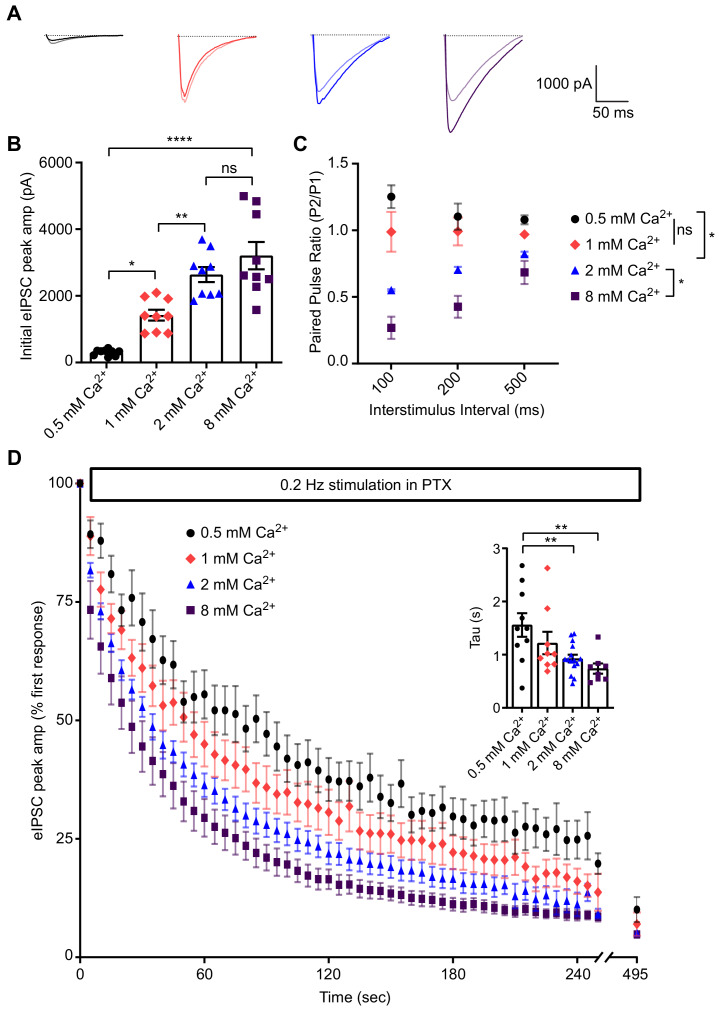
PTX can be used to compare release probability of inhibitory synapses.(A) Example traces of paired pulse responses at an interstimulus interval of 100 ms in 0.5 mM Ca2+ (pulse one black, pulse two gray), 1 mM Ca2+ (pulse one pink, pulse two light pink), 2 mM Ca2+ (pulse one blue, pulse two light blue) or 8 mM Ca2+ (pulse one purple, pulse two light purple). (B) Quantification of initial peak amplitude of eIPSC in different Ca2+ concentrations. Increasing Ca2+ concentration increases the initial peak eIPSC amplitude, consistent with increased release probability (one-way ANOVA F(3,32) = 27.24, p<0.0001, Tukey’s post-hoc testing 0.5 mM Ca2+ vs 1 mM Ca2+ p=0.0160, 1 mM Ca2+ vs 2 mM Ca2+ p=0.0079, 2 mM Ca2+ vs 8 mM Ca2+ p=0.3821, 0.5 mM Ca2+ vs 8 mM Ca2+ p<0.0001, n = 9 all groups). (C) Paired pulse ratio recorded from cells in different Ca2+ concentrations. Increasing Ca2+ concentration decreased paired pulse ratio, consistent with increased release probability (two-way ANOVA interaction F(6,26) = 2.801, p=0.0308, interevent interval factor F(2,26) = 2.220, p=0.1287, Ca2+ concentration factor F(3,26) = 43.55, p<0.0001, Tukey’s post-hoc testing 0.5 mM Ca2+ vs 1 mM Ca2+ p=0.1202, 1 mM Ca2+ vs 2 mM Ca2+ p=0.0024, 2 mM Ca2+ vs 8 mM Ca2+ p=0.0107, 0.5 mM Ca2+ vs 8 mM Ca2+ p<0.0001, n = 3 for 0.5 mM Ca2+; n = 3 for 1 mM Ca2+; n = 3 for 2 mM Ca2+; n = 4 for 8 mM Ca2+). (D) eIPSC peak amplitude over successive 0.2 Hz stimulations in the presence of PTX. Increasing Ca2+ concentration increased the rate of eIPSC block. (Inset) Individual time constants of single exponentials fitted to each experiment. Increasing Ca2+ concentration decreased the time constant, consistent with an increased rate of block, demonstrating the utility of PTX to estimate release probability (one-way ANOVA F(3,38) = 5.125, p=0.0045, Tukey’s post-hoc testing 0.5 mM Ca2+ vs 1 mM Ca2+ p=0.4468, 0.5 mM Ca2+ vs 2 mM Ca2+ p=0.0162, 0.5 mM Ca2+ vs 8 mM Ca2+ p=0.0062, 2 mM Ca2+ vs 8 mM Ca2+ p=0.8203, n=10 for 0.5 mM Ca2+; n = 8 for 1 mM Ca2+; n = 14 for 2 mM Ca2+; n = 9 for 8 mM Ca2+). Graphs are mean ± SEM. * indicates p<0.05, ** indicates p<0.01, **** indicates p<0.0001, ns indicates not significant.Figure 2—source data 1.Source data for Figure 2.